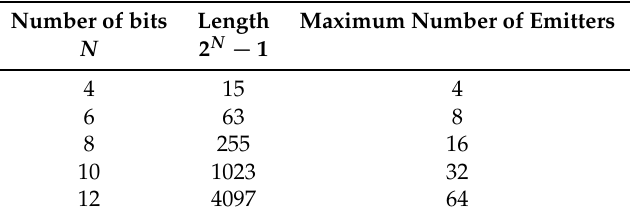
Table 1. Length of sequences and maximum number of emitters in Kasami